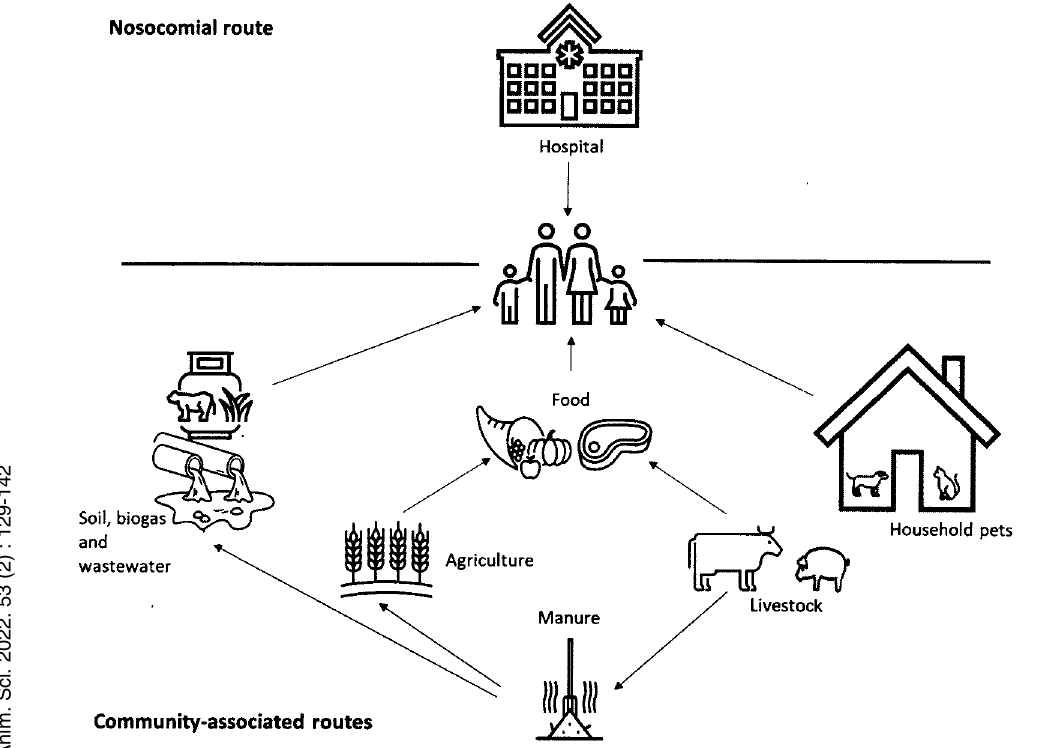
Fig. 1. Sources of C. difficile transmission routes to